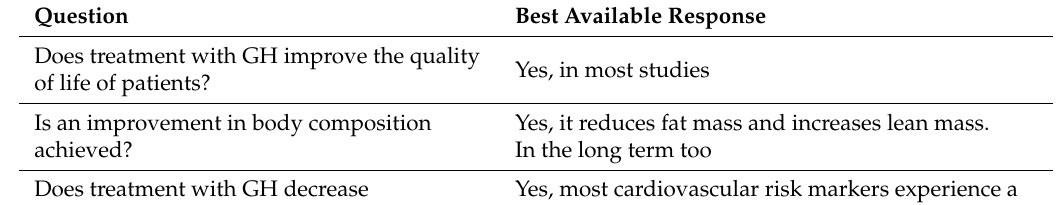
Table 4. Questions and answers about GH replacement therapy in adults with